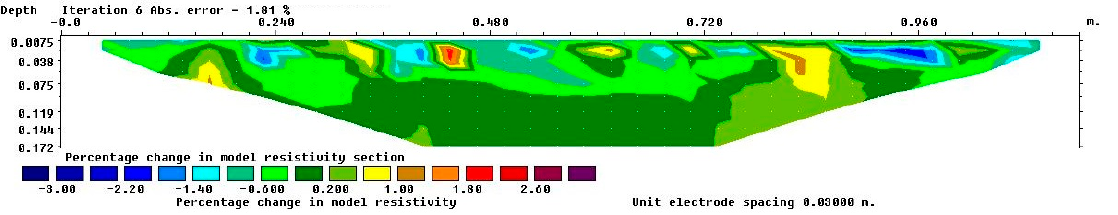
Figure 3. Percentage change in resistivity of datasets acquired at the end of the test when no more changes occurred and the levee condition was supposed to have reached a stable status. Observed resistivity changes are attributed to the background